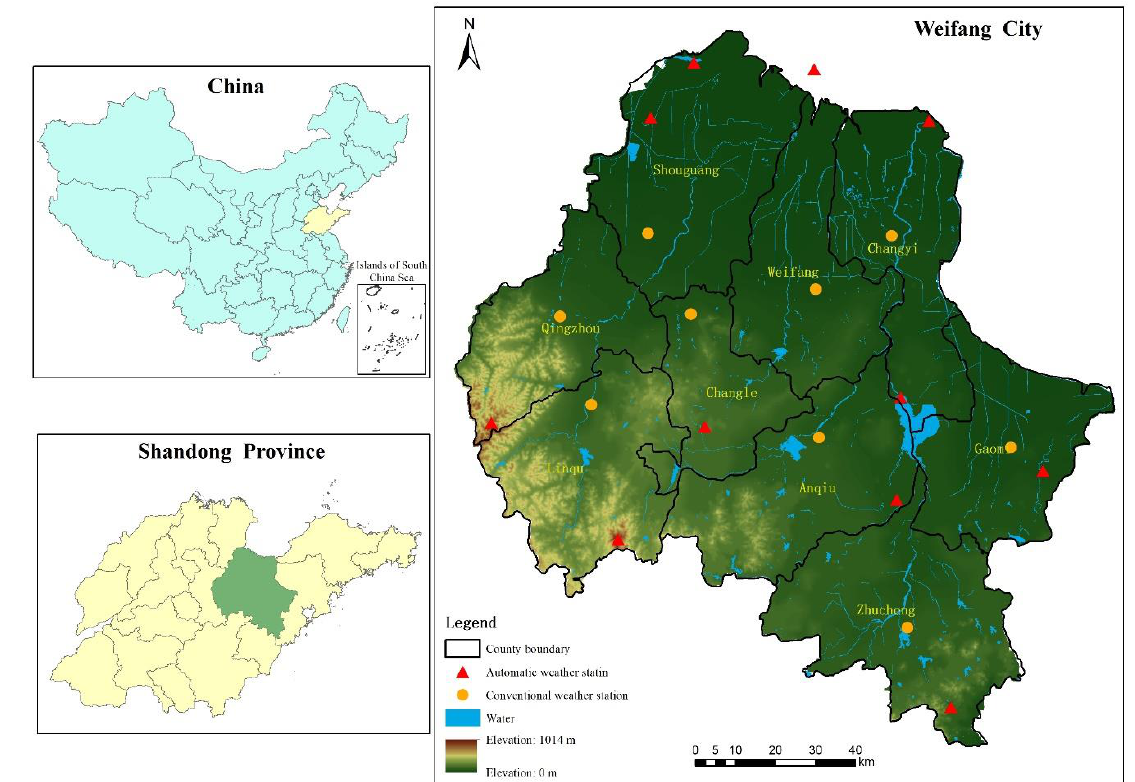
Figure 1. Distribution of monitoring stations.